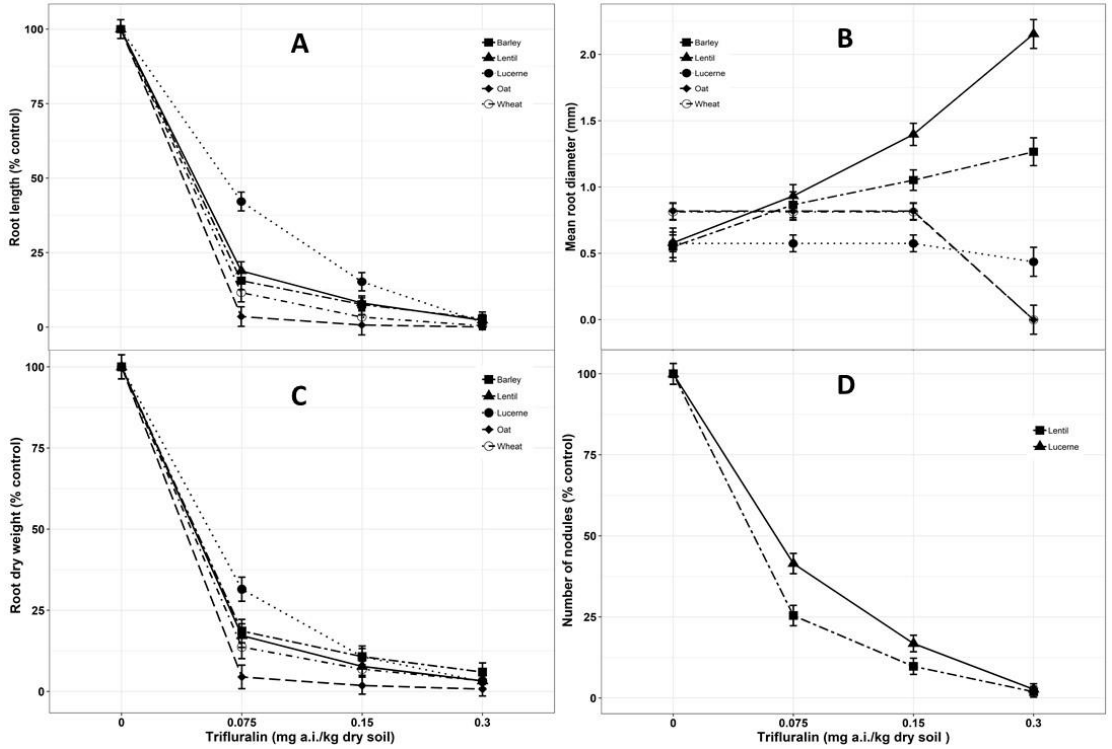
Figure 2. Effect of various levels of trifluralin concentrations on root parameters ( A . Root length; B . Mean root diameter; C . Root dry weight; D . Number of nodules) of barley, lentil, lucerne, oat and wheat at 28 days after sowing (DAS). Lines denote predicted responses according to the equations reported in the materials and methods section. Symbols shown on the graphs are the original means of each parameter (% control) against each dose of trifluralin concentration. Mean value was pooled from eight observational